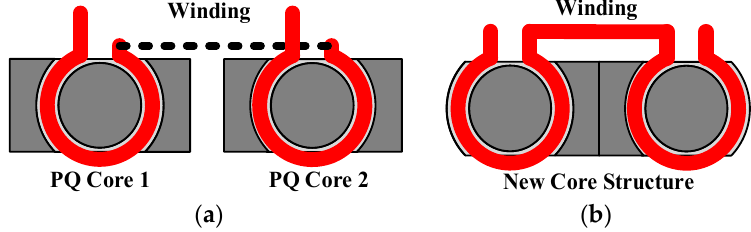
Figure 9. Diagram of the innovative core structure: ( a ) PQ core structure; ( b ) the innovative core structure.